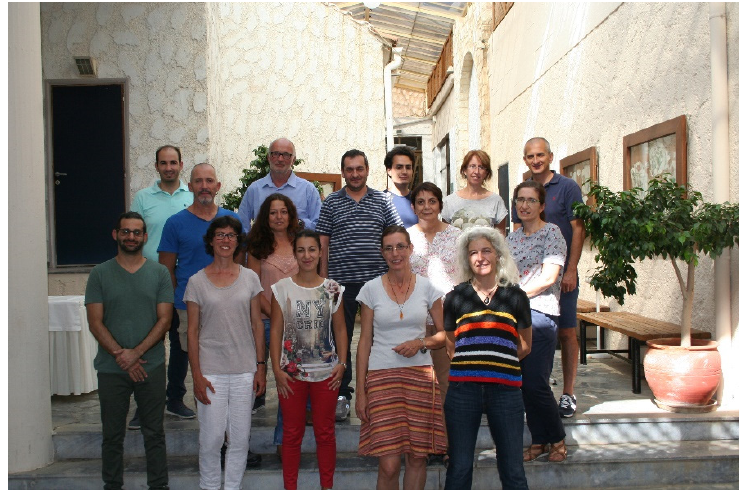
Figure 2. IUCN/SSC Mediterranean plant specialist